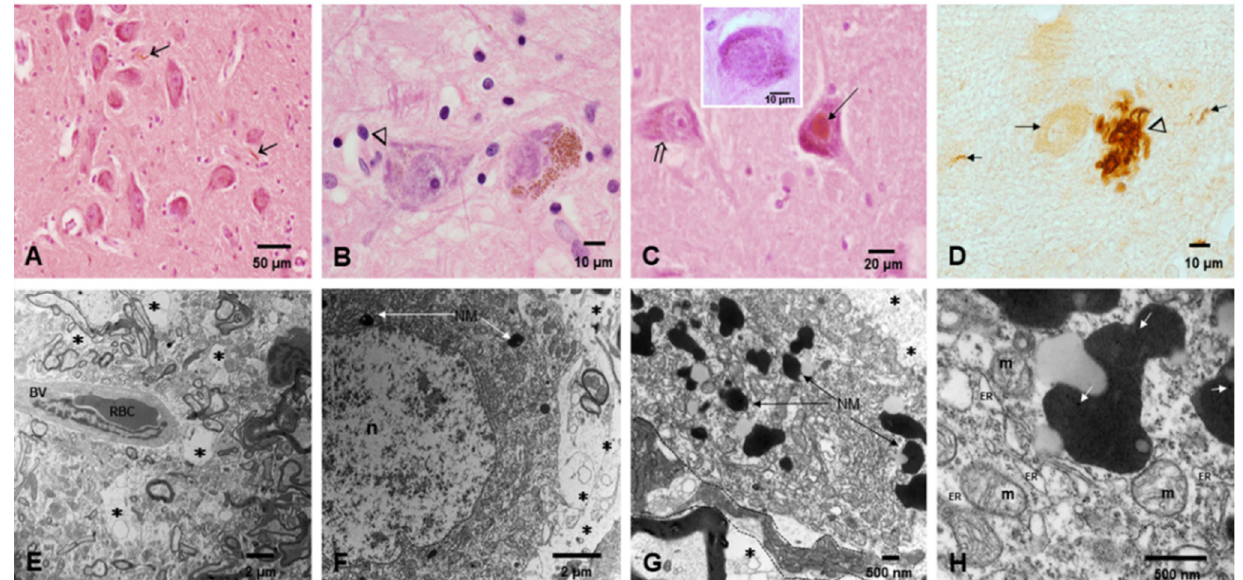
Figure 4. Substantia nigrae pars compacta SNpc. ( A ). Fourteen-year-old child with numerous + P τ (arrows) in the SN pc. ( B ). Seventeen year-old male with contrasting SNsc neurons, the one on the left (arrow head) displays very little neuromelanin. ( C ). Eleven-year-old boy with intense nuclear P τ (short arrow) alongside intracytoplasmic + P τ (arrowhead)immunoreactivity. The insert shows a Lewybody like inclusion. ( D ). P τ mature plaques (arrow head) and neurites (short arrows) are common in subjects ≥ 30 years with SNps neurons devoid of neuromelanin (long arrow). ( E ). TEM in a 3-year-old child with significant fragmentation and vacuolization (*) of the neuropil surrounding the blood vessel. ( F ). Same as ( E ), a neuron shows very few neuromelanin granules (white arrows), an apparently intact nucleus (n) and a significantly fragmented neuropil (*). ( G ). The amount of neuromelanin goes up in adults along significant neuropil fragmentation (*). ( H ). Neuromelanin granules with NPs (white arrows), abnormal mitochondria (M) and markedly dilated endoplasmic reticulum (ER).